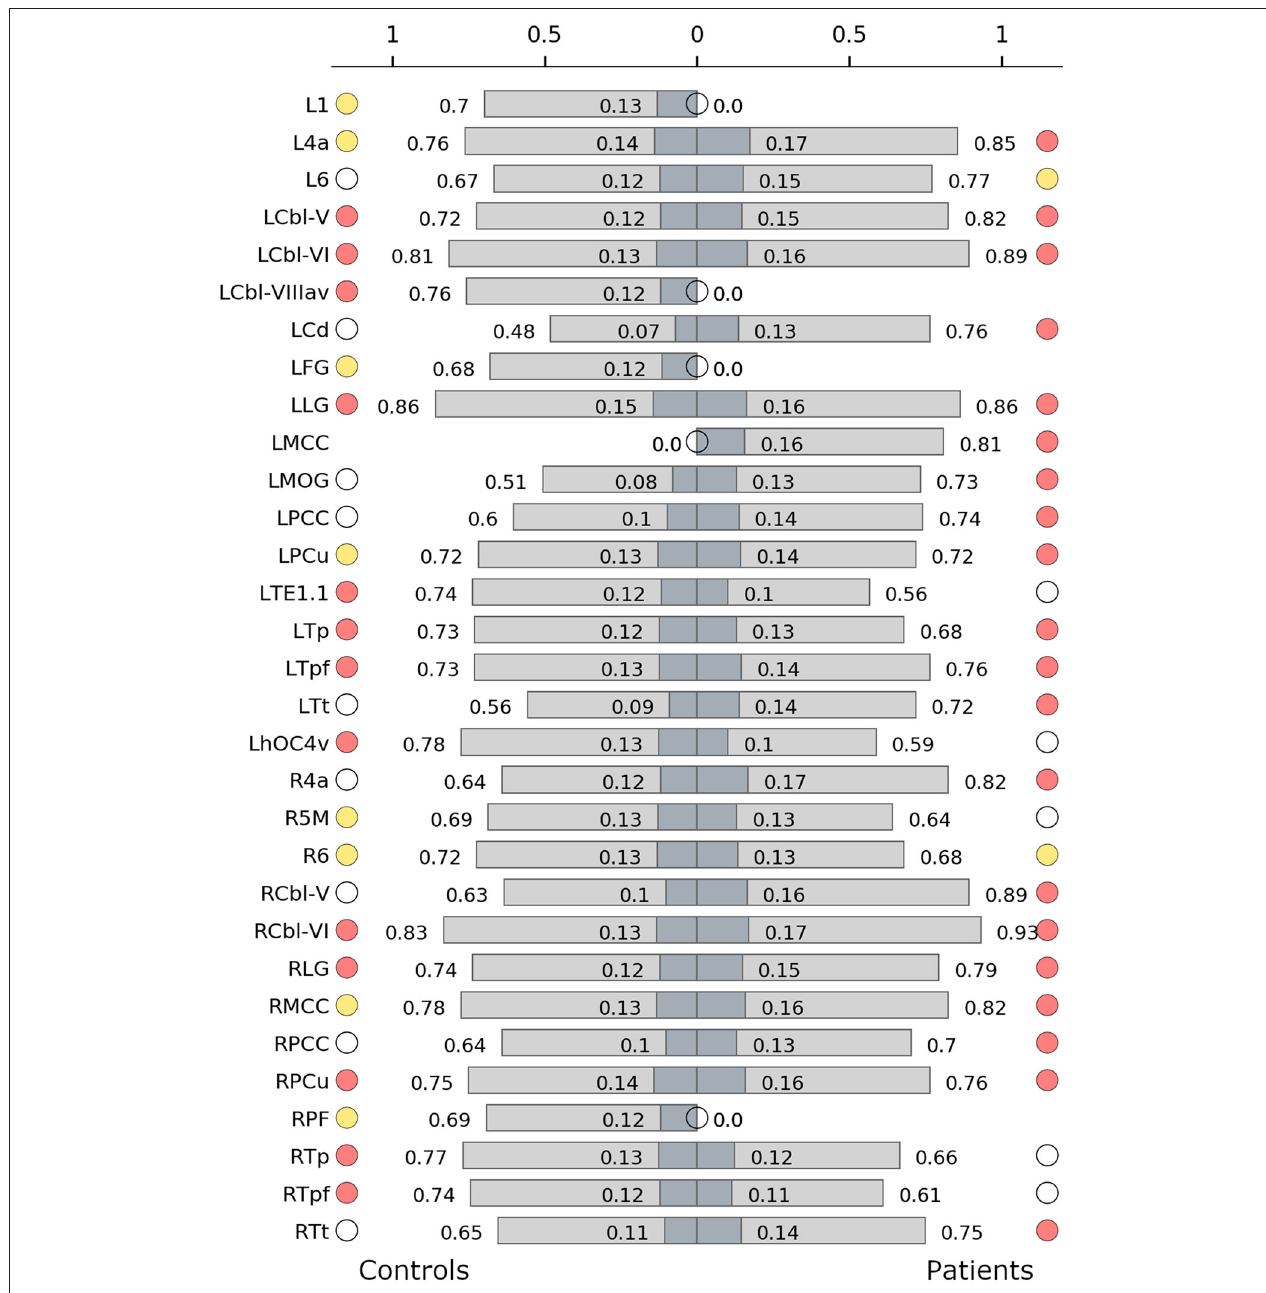
FIGURE 2 | Hub characteristics of the control (left) and the patient network (right) . The graph shows all nodes that were recruited as hubs in either of the two networks. For each hub, normalized nodal degree (light grey) and normalized nodal strength (dark grey) are indicated by bars. White circles denote nodes that were not hubs in the respective network, absence of circles denotes that the node was not present in the respective network. Red circles denote connector hubs, yellow circles denote provincial hubs. 1/6, BAs 1/6; 4a, anterior part of BA 4; 5M, subdivisions of BA 5; Cbl V/VI/VIIIav, cerebellar lobules V/VI/VIIIa vermis; Cd, caudate nucleus; FG, fusiform gyrus; hOC4v, ventral part of area hOC4; MOG, middle occipital gyrus; LG, lingual gyrus; MCC/PCC, middle/posterior cingulate cortex; PCu, precuneus; PF, area PF in the inferior parietal cortex; TE1.1, area TE1.1; Tp/Tpf/Tt, parietal/prefrontal/temporal subdivision of the thalamus; L, left; R, right.